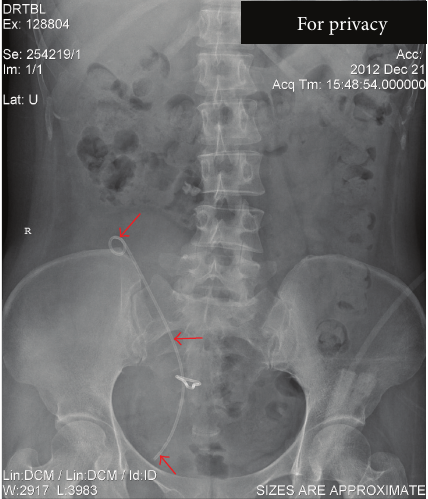
Figure 1: Preoperative kidney-ureter-bladder radiography image. The modified (by cutting a length of 9 cm from one end of the classical 25 cm full length) double J stent run from kidney to bladder was indicated with the red arrows.